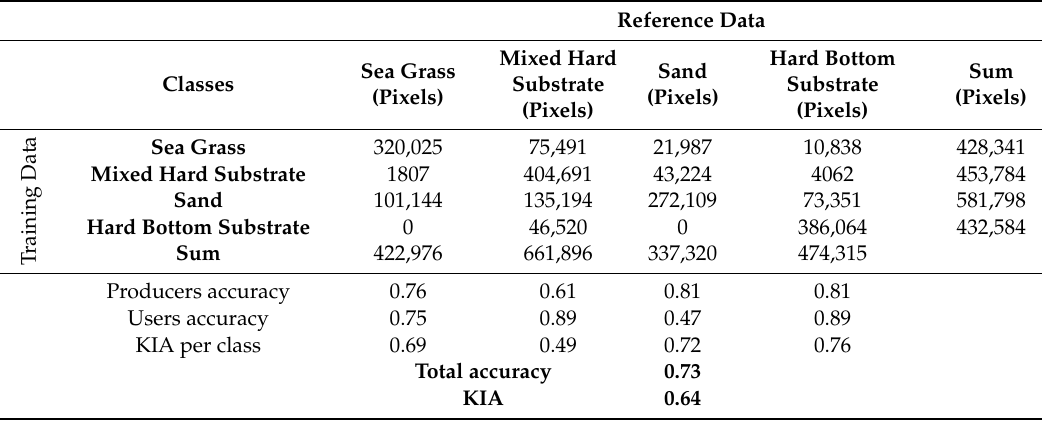
Table 6. Accuracy matrix for the tc-RGB orthomosaic applying the fuzzy rules.